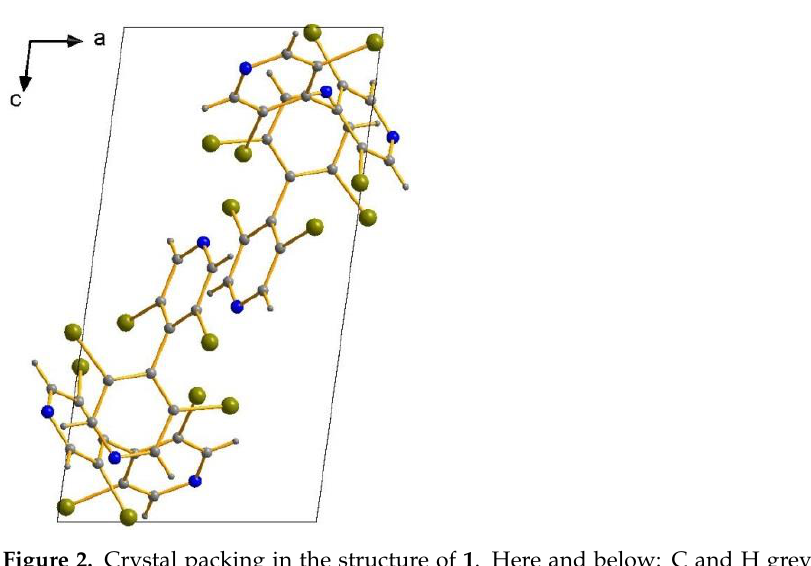
Figure 1. 3,3 (cid:48) ,5,5 (cid:48) -tetrabromo-4,4 (cid:48) -bipyridine (BrBipy). Figure 1. 3,3′,5,5′ - tetrabromo - 4,4′ - bipyridine (BrBipy). Figure 1. 3,3′,5,5′ - tetrabromo - 4,4′ - bipyridine (BrBipy).